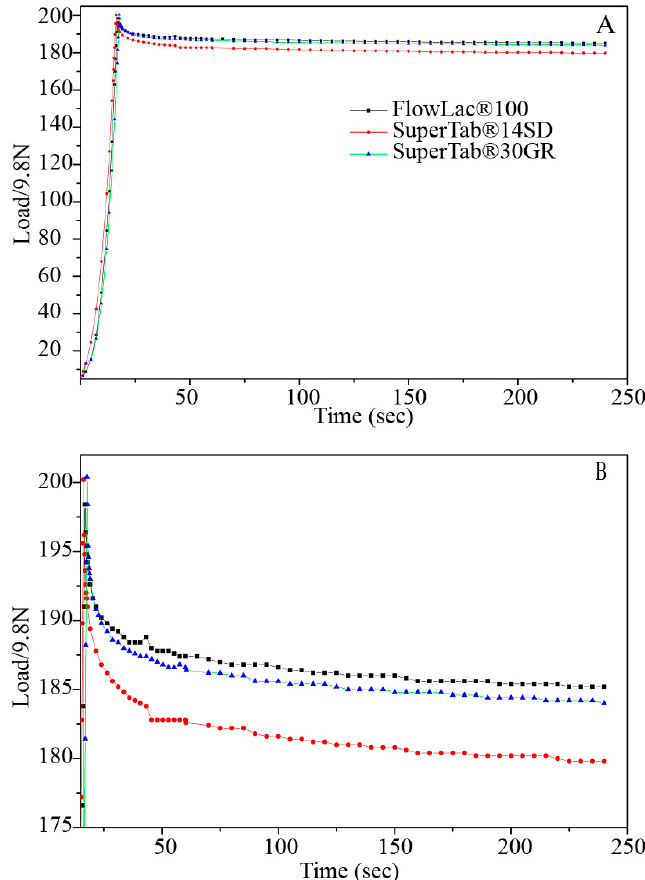
Figure 1. ( A ) The stress-relaxation curves of lactose monohydrate (Y-axis: 0-200 sec). ( B ) The stress-relaxation curves of lactose monohydrate (Y-axis: 175-200 sec).